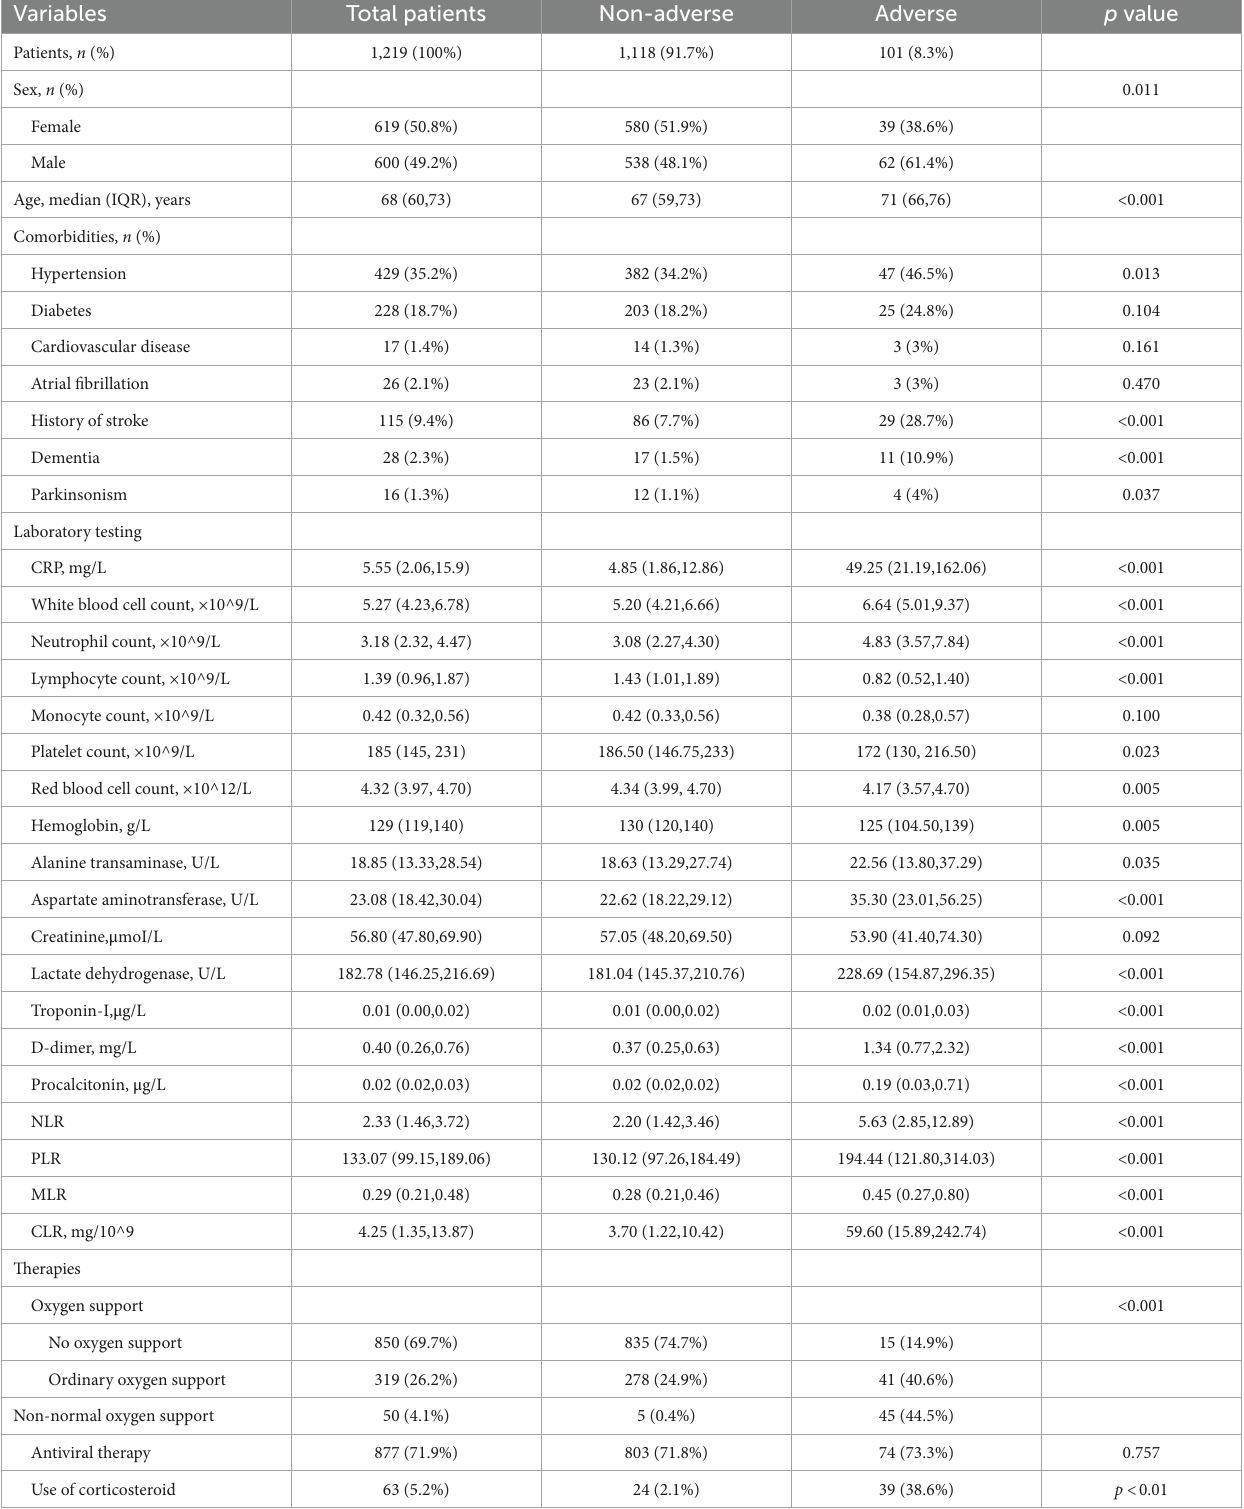
TABLE 1 Baseline characteristics of patients with adverse and non-adverse outcomes. Variables Total patients